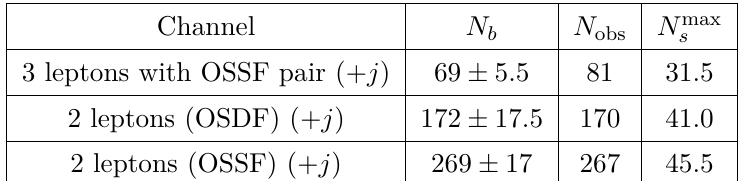
Table 6 . 95% probability bounds on the number of signal events, N max